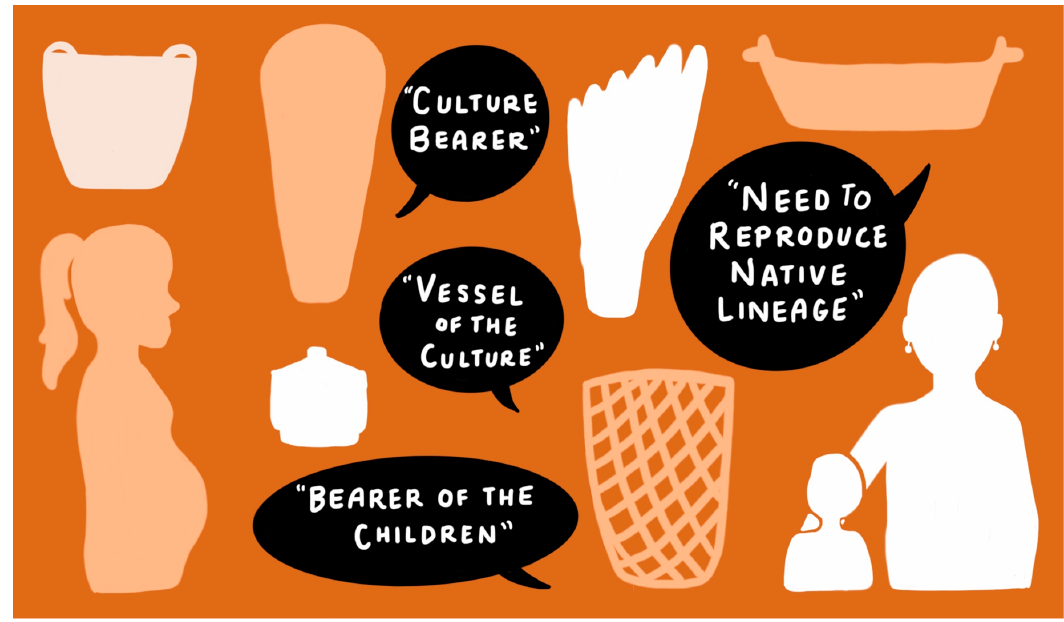
Figure 13. A collage of phrases including vessel of the culture and culture bearer are matched with silhouettes vessels including baskets, bowls, and a cradleboard. See I.D. 13 in Appendix A.